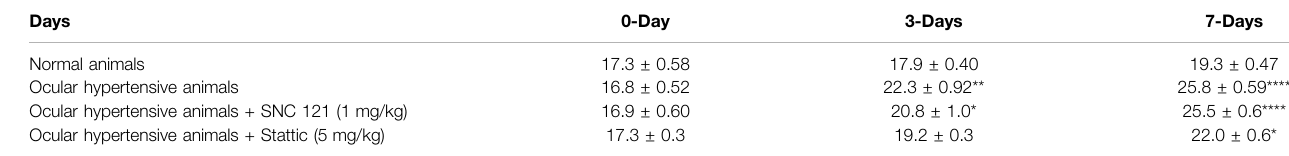
TABLE 3 | Measurements of IOP in normal, ocular hypertensive, SNC-121, and stattic treated ocular hypertensive animals. Days Normal animals